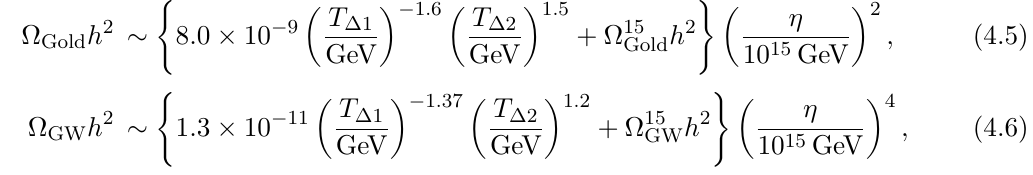
, and from kination to ∆2 , T ). The red ∆1 ∆2